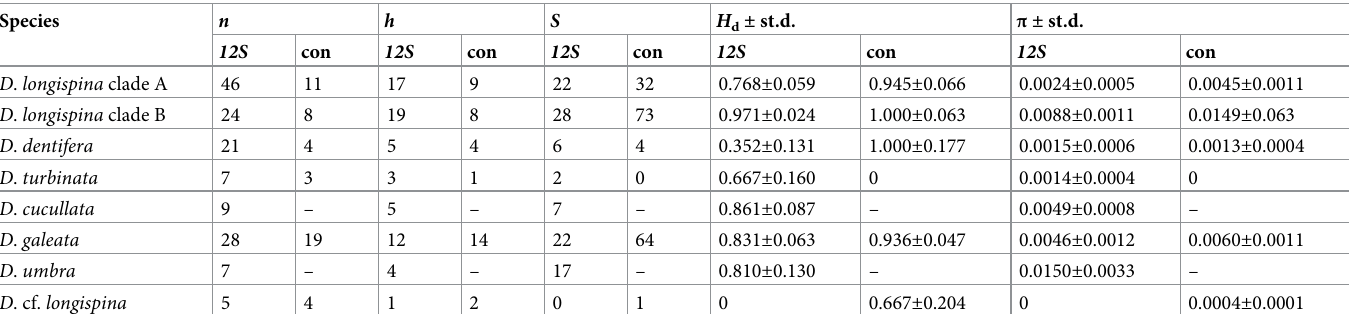
Table 1. Polymorphism of the mtDNA based on the original 12S and concatenated 12S + 16S + ND2 datasets for the studied Daphnia species and D . longispina clades. Abbreviations: con, concatenated fragment ( 12S + 16S + ND2 ); n , number of sequenced Daphnia individuals; S , number of polymorphic sites; h , number of haplotypes; H d , haplotype diversity; π , nucleotide diversity; st.d., standard deviation.